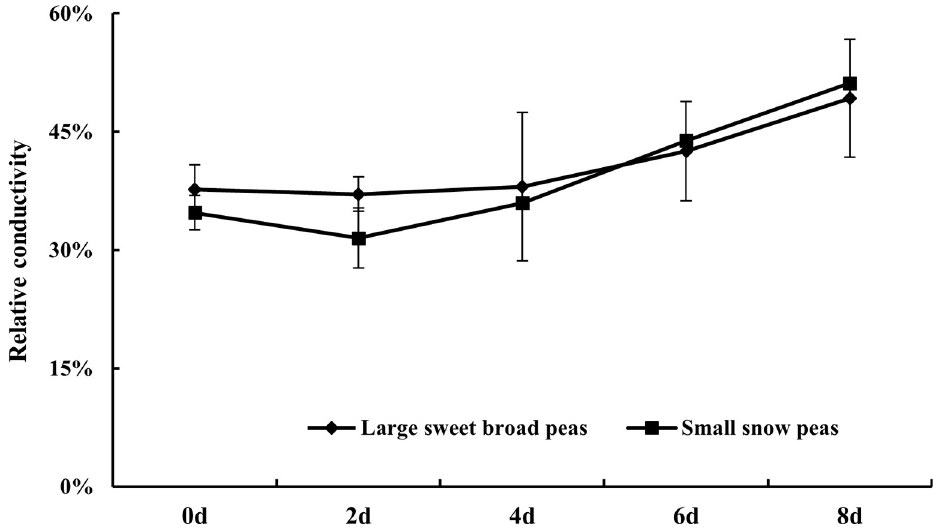
Fig 2. Changes in relative conductivity of two types of snow peas during storage.